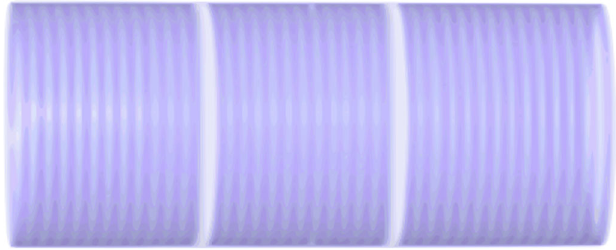
FIG. 4. A depiction of a two-quasihole dressed domain-wall state. These states are adiabatically evolved from the bare thin torus domain-wall states but live on the full-sized torus. The quasiholes described by this state are localized at some position in the x direction but delocalized in the y